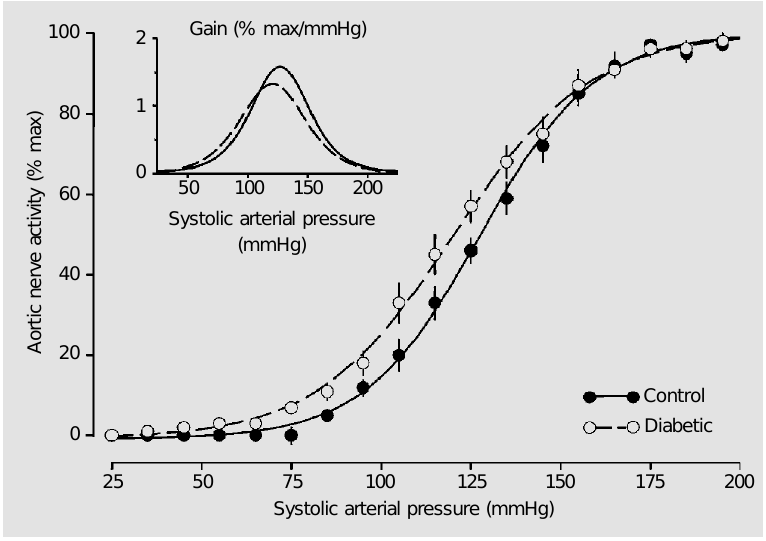
Figure 3. Pressure nerve activity curve expressed as percentage of maximal activity versus mean arterial pressure using logistic sigmoidal regression in control (N = 14) and diabetic rats (N = 17). Inset shows the gain of the relationship in both